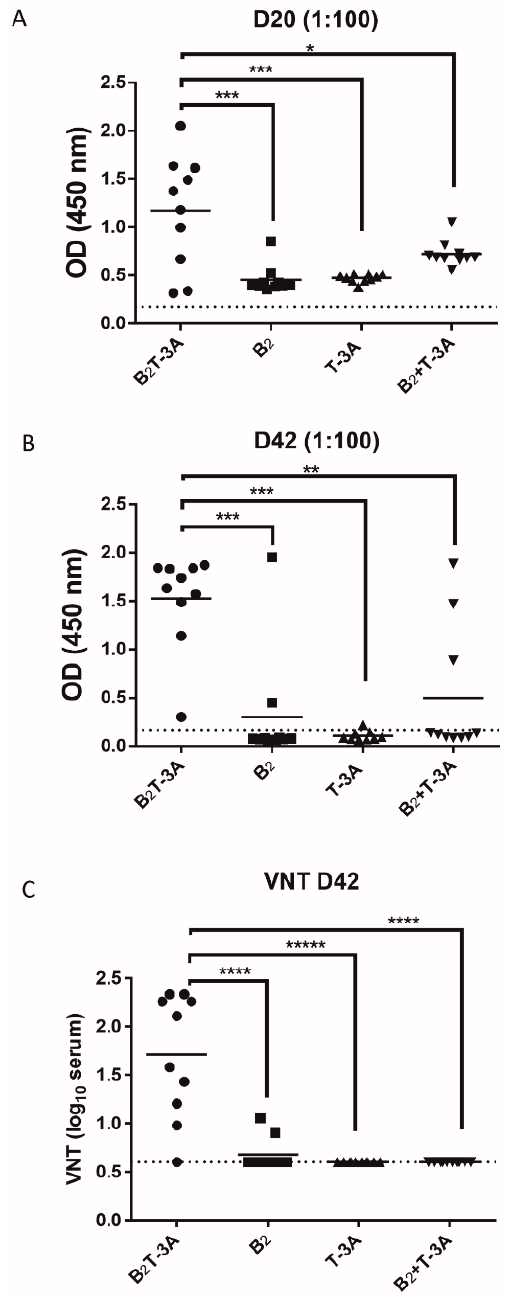
Figure 1. Incorporation of both B- and T-cell epitopes is required for efficient induction of FMDV- specific antibodies by FMDV dendrimers. Antibodies in sera from groups of animals (n = 10 Swiss mice) immunized twice (on days 0 and 20) with 0.1 mg/dose of B 2 T-3A, B 2 +T-3A, B 2 or T-3A. ELISA titers against B 2 peptide at 20 days pi ( A ) and 42 days pi ( B ). Virus-neutralizing antibody titers (VNT) on day 42 pi against O/UK/11/2001, a type O FMDV isolate whose sequence is homologous to those of the B 2 and T-3A peptides ( C ). Each point represents the mean of a triplicate assay for each mouse. Dotted lines indicate the detection limit of the assay. Values are expressed as the reciprocal log 10 of the serum dilution that neutralized 100 TCID 50 of FMDV. Statistically significant differences are indicated by asterisks (*) for p < 0.05, (**) for p < 0.01, (***) for p < 0.001, (****) for p < 0.0001, and (*****) for p < 0.00001.